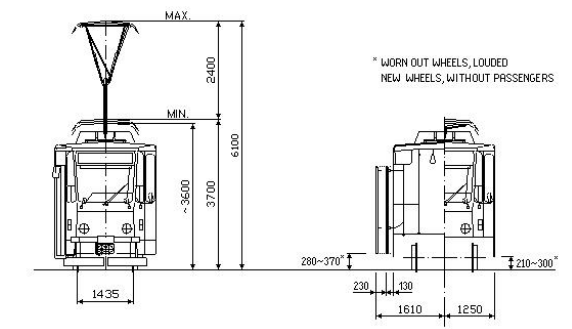
Figure 2. T6A5 tram – cross section, including the tilting door movement – plotting in a type drawing [16].